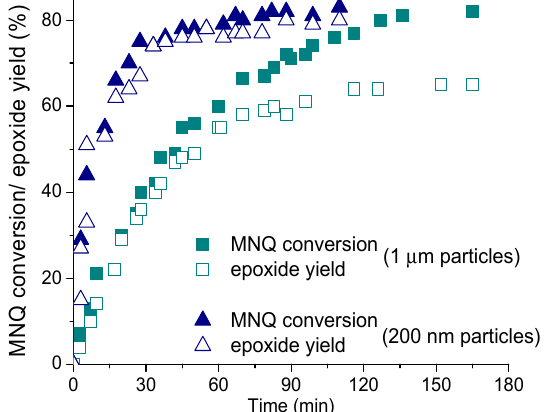
Figure 3. Plots of 2-methyl-naphthoquinone (MNQ) conversion and epoxide yield vs. time over ZIF-8 with different particle size. Reaction conditions: MNQ 0.1 mmol, H 2 O 2 0.8 mmol, catalyst 3.3 mg, CH 3 CN 1 mL, and 70 °C.